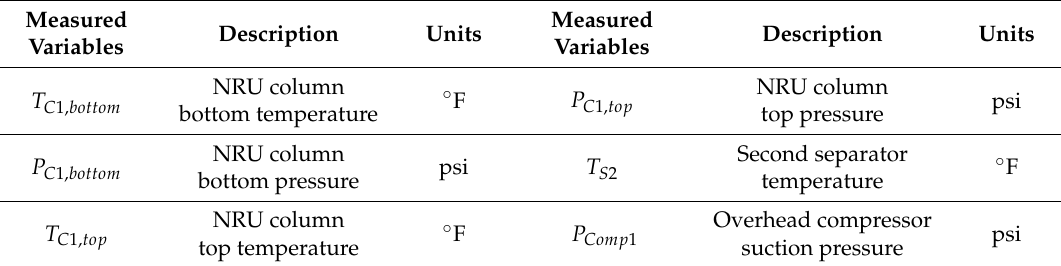
Table 2. NRU operating